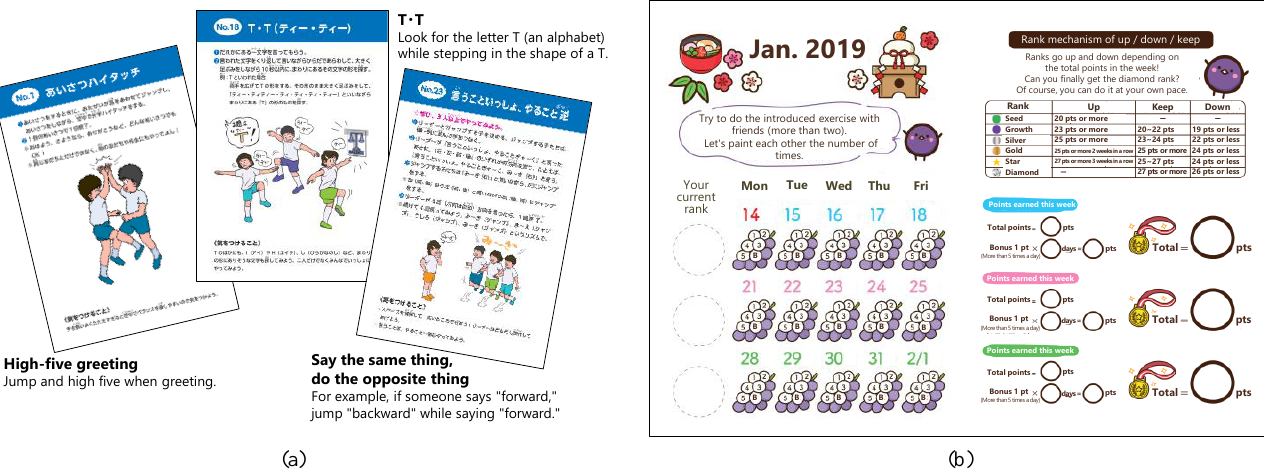
Figure 2. Examples of the instruction manual sheets for activities ( a ) and recording card used in the programme (example month: January) ( b ).